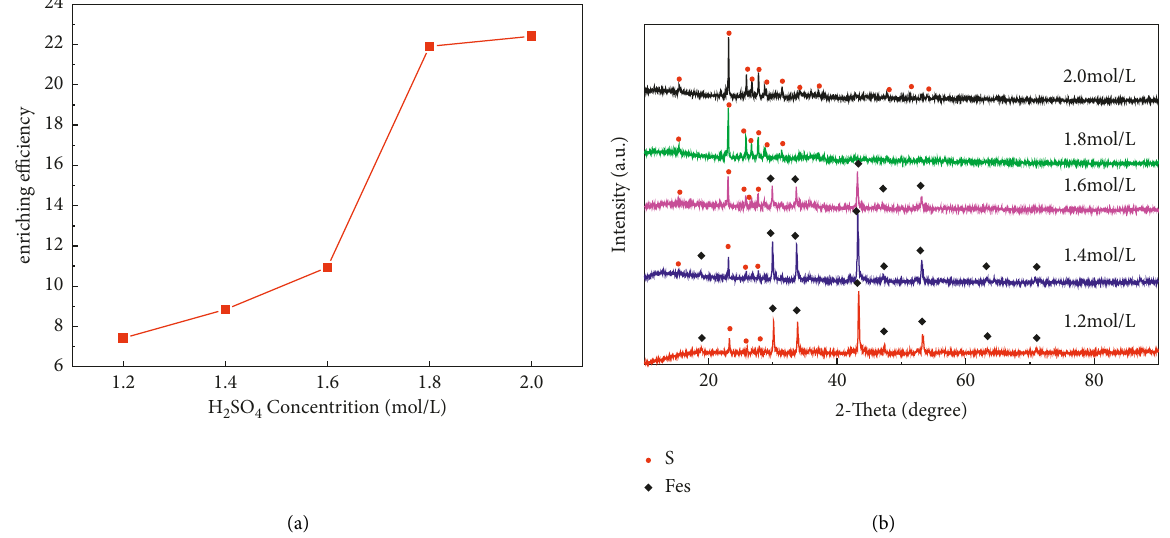
Figure 6: Effects on (a) Pt enriching efficiency and (b) XRD analysis of acid leaching residue with different